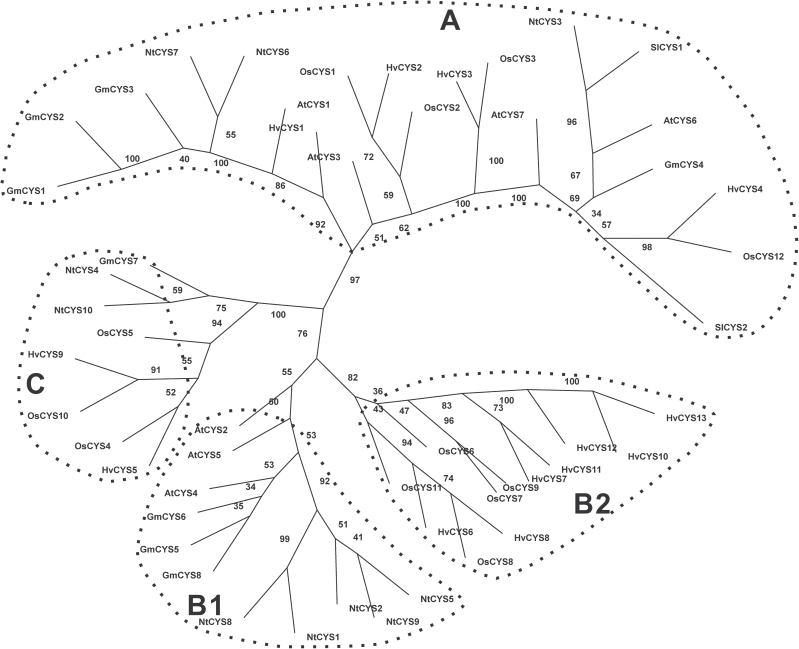
Phylogenetic relationships of the cystatins from Nicotians tabacum, Arabidopsis thaliana, Glycine max, Oryza sativa, Hordeum vulgare, and Solanum lycopersicum. The tree was calculated with Phylip Ver. 3.68 software using the Protpars method. The numbers at the nodes indicate the bootstrap values. Accession numbers of the protein sequences used in this analysis were as follows: A. thaliana AtCYS1 (AT5G12140), AtCYS2 (AT2G31980), AtCYS3 (AT3G12490), AtCYS4 (AT4G16500), AtCYS5 (AT5G47550), AtCYS6 (At3g12490), AtCYS7 (At5g05110); G. max GmCYS1 (ACU14306), GmCYS2 (CAI84599), GmCYS3 (CAI84598), GmCYS4 (BAA19610), GmCYS5 (ACU19522), GmCYS6 (ACU14962), GmCYS7 (CAI84604), GmCYS8 (CAI84601); O. sativa OsCYS1 (Os01g58890), OsCYS2 (Os05g41460),OsCYS3 (Os05g33880), OsCYS4 (Os01g68660), OsCYS5 (Os01g68670), OsCYS6 (Os03g11180), OsCYS7 (Os03g11170), OsCYS8 (Os03g31510), OsCYS9 (Os03g11160), OsCYS10 (Os04g28250), OsCYS11 (Os09g08100), OsCYS12 (Os01g16430); H. vulgare HvCYS1 (Y12068), HvCYS2 (AJ748337), HvCYS3 (AJ748338), HvCYS4 (AJ748344), HvCYS5 (AJ748340), HvCYS6 (AJ748341), HvCYS7 (AJ748345), HvCYS8 (AJ748343), HvCYS9 (AJ748339), HvCYS10 (AJ748342), HvCYS11 (AJ748346), HvCYS12 (AJ748347), HvCYS13 (AJ748348); and S. lycopersicum SlCYS1 (AAF23126), SlCYS2 (ABG23376).